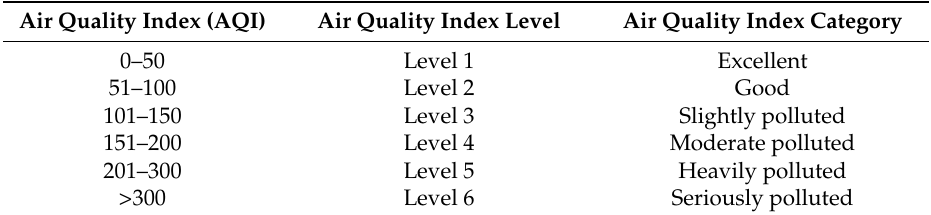
Table 1. Grading standard of air